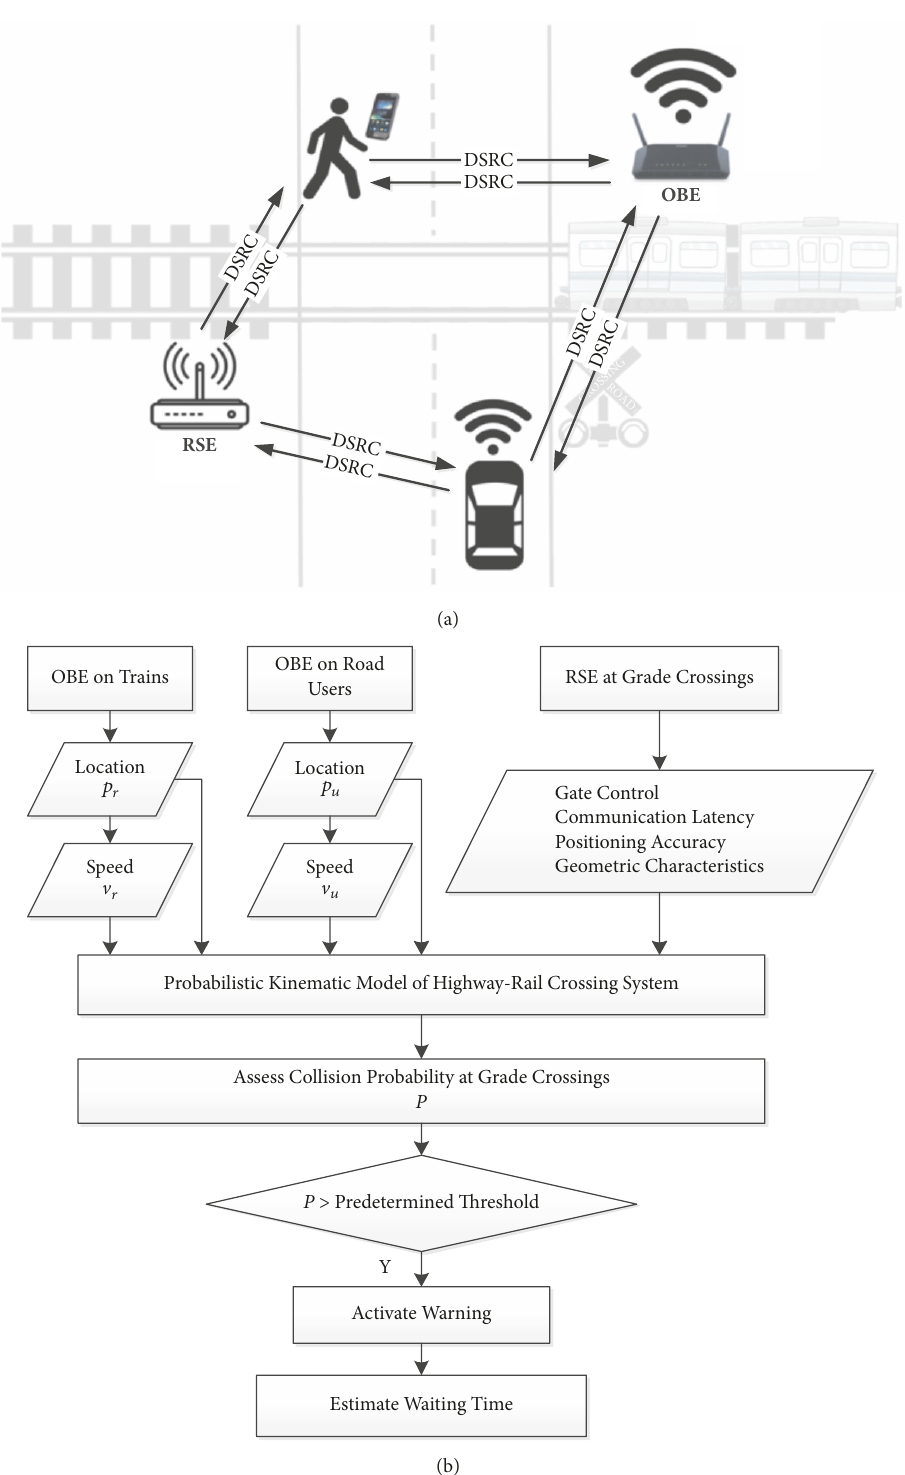
Figure 1: System framework. (a) Conceptual communication framework. (b) System